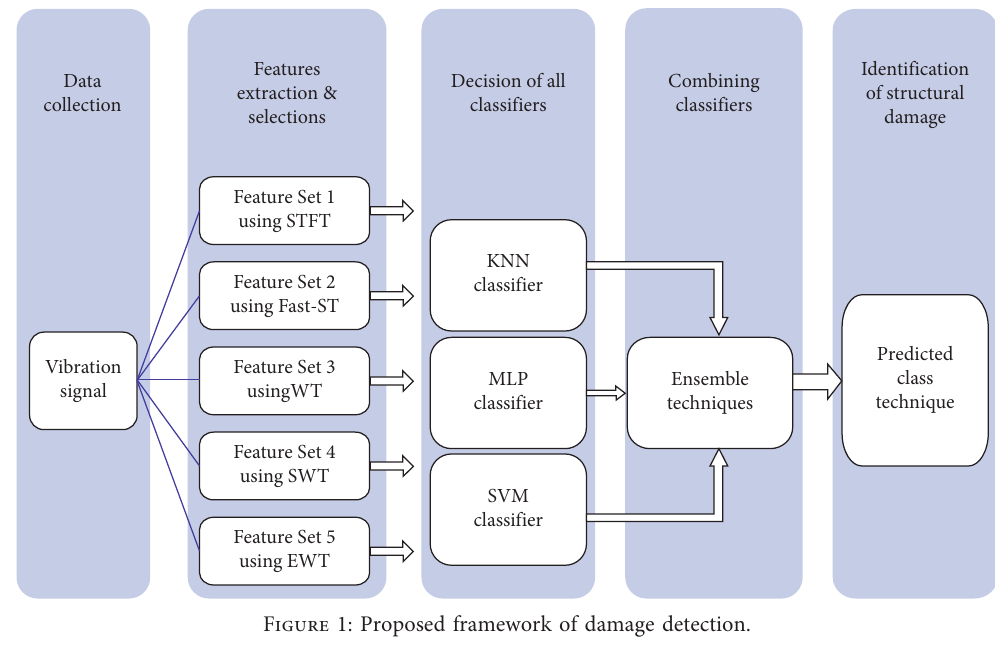
Figure 1: Proposed framework of damage detection.